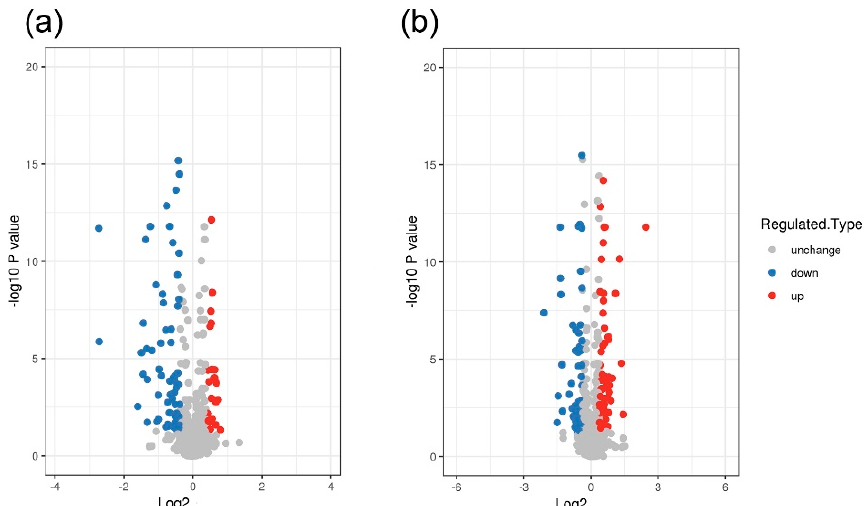
Figure 1. ( a ) Volcano plot of gestation-pen and farrowing-pen combined housing system (PP) vs gestation-crate and farrowing-crate combined housing system (CC) differential expression protein. ( b ) Volcano plot of gestation-pen and farrowing-crate combined housing system (PC) vs CC differential expression protein. Note: Ratio of differential protein expression over 1.3 was the significant change threshold ( p < 0.05).